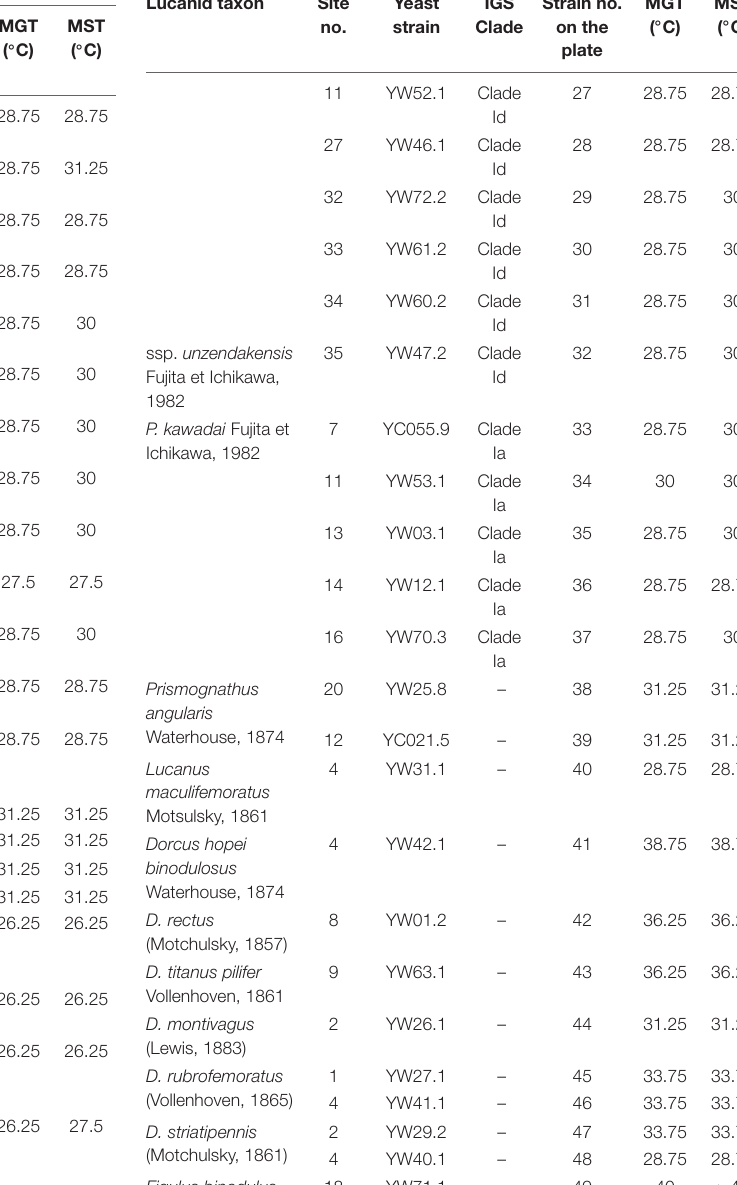
Yeast IGS Strain no. no. strain Clade on